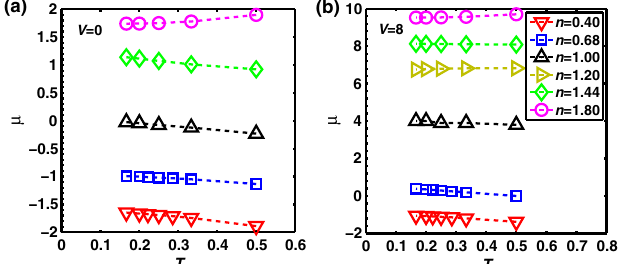
FIG. 10. The chemical potential μ ð T Þ is tuned to maintain the filling n unchanged at all temperatures. V ¼ 0 in (a), and V ¼ 8 in (b). The system size is L ¼ 8